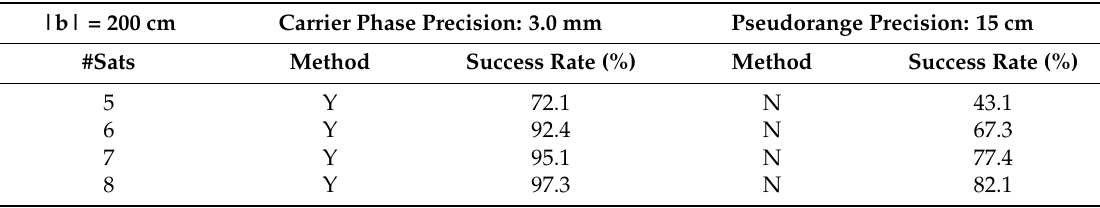
Table 1. Single-frequency, single-epoch, GNSS ambiguity success rates based on Equation (17) and Equation (18) for the processing (Y) and not-processing (N) RMM-AFM methods. |b| = 200 cm Carrier Phase Precision: 3.0 mm